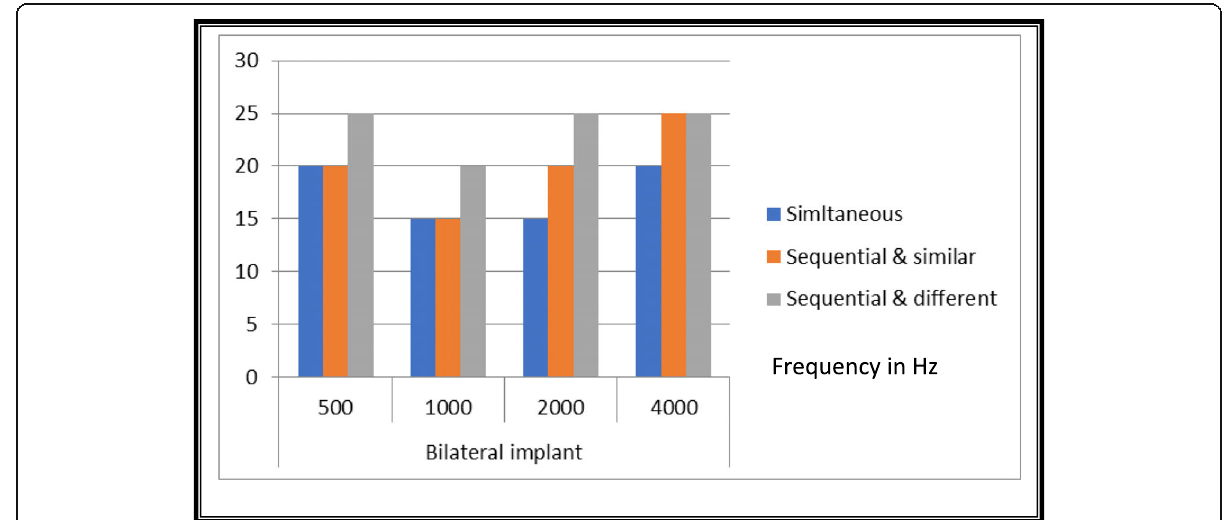
Fig. 1 Comparison of the aided threshold with simultaneous versus sequential similar and different bilateral implants 6 months after the second